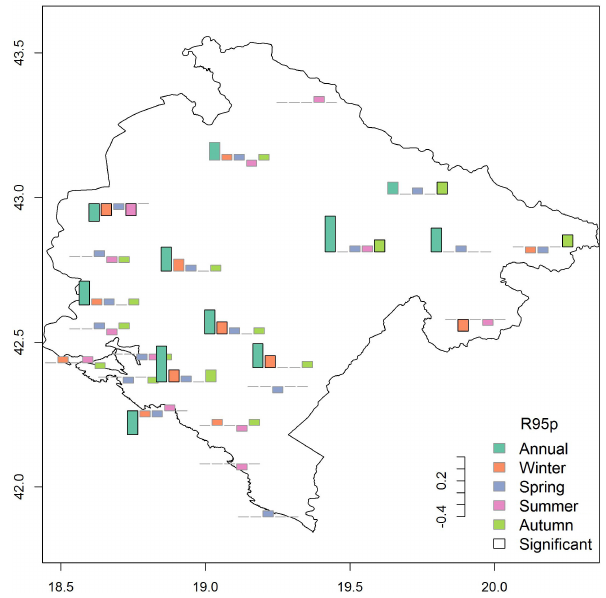
Figure 7. Decadal trends in the annual and seasonal rainfall above 95th percentile (R95p) in daydec − 1